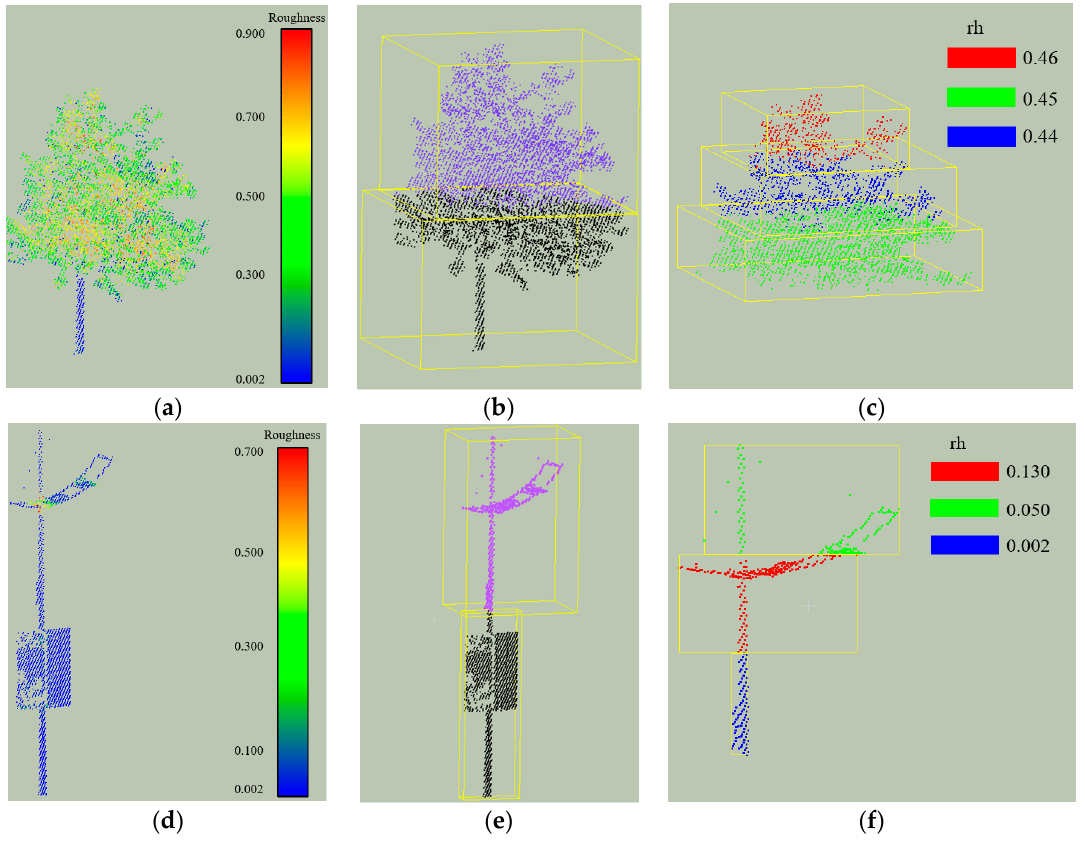
Figure 5. Roughness distributions of two isolated point cloud clusters. ( a ) The roughness value distribution of the tree points. ( b ) Sectioning the tree to upper part and lower part. ( c ) Three sections from the upper part of the tree and the average roughness value ( rh ) of each section. ( d ) The roughness value distribution of the lamppost points. ( e ) Sectioning the lamppost to upper part and lower part. ( f ) Three sections from the upper part of the lamppost and the average roughness value ( rh ) of each section.